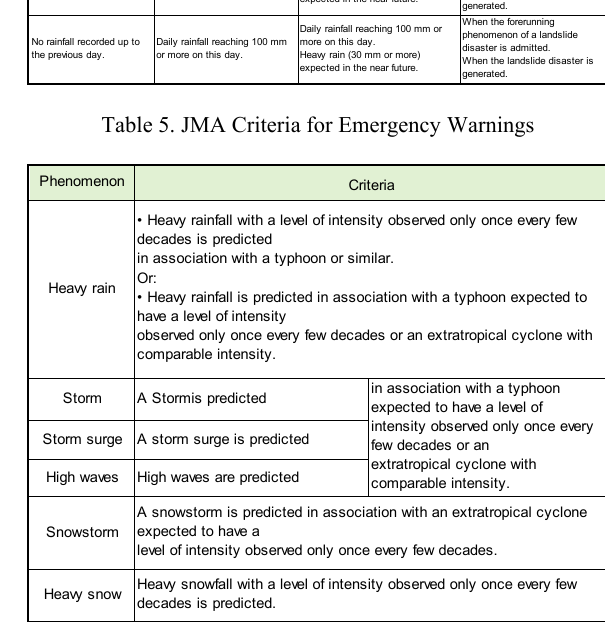
Table 4. Precaution shelter standards during a sediment disaster Rainfall for one hour (mm) Shelter preparation information Evacuation order Evacuation directive Continuous rainfall reaching 100 mm or more on the previous day.